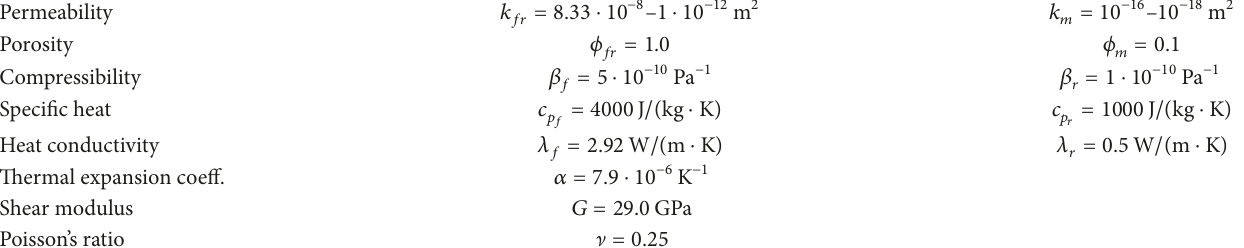
Table 2: Properties used in the fluid injection simulation. Subscripts: fr , fracture; m , matrix; f , fluid; r , rock. Permeability